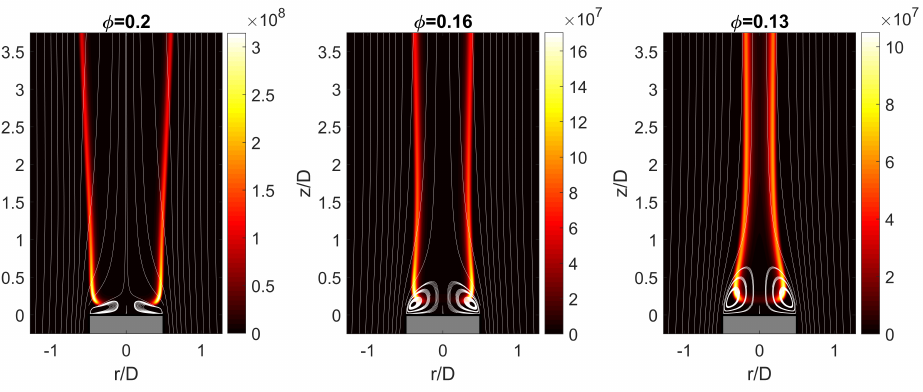
Figure 3. Heat release rate contours in Wm − 3 along with streamlines (white lines) from numerical simulations for flames away from extinction.